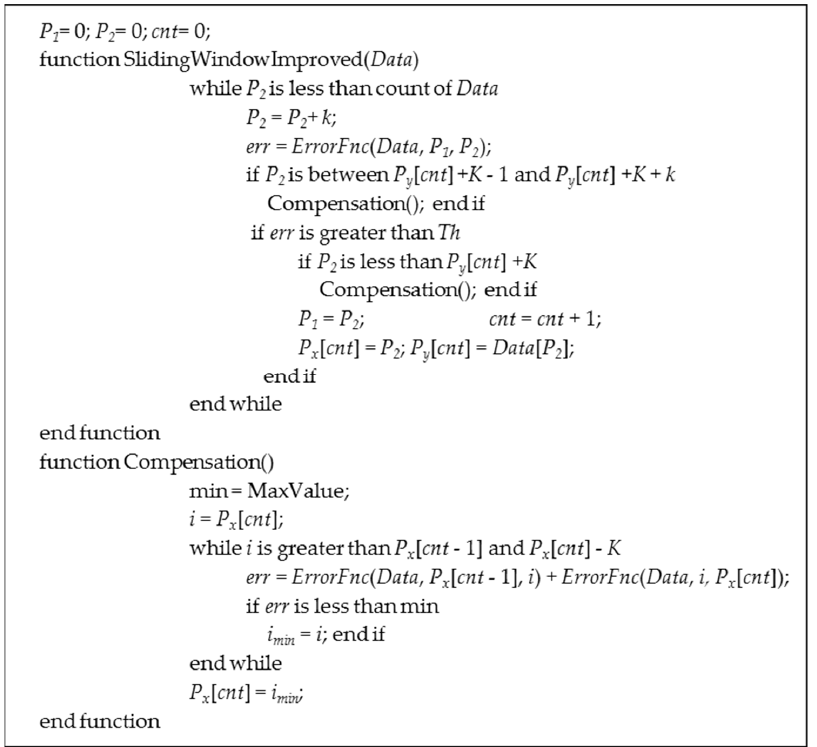
Figure 5. Pseudo codes of modified sliding window method for PLA.